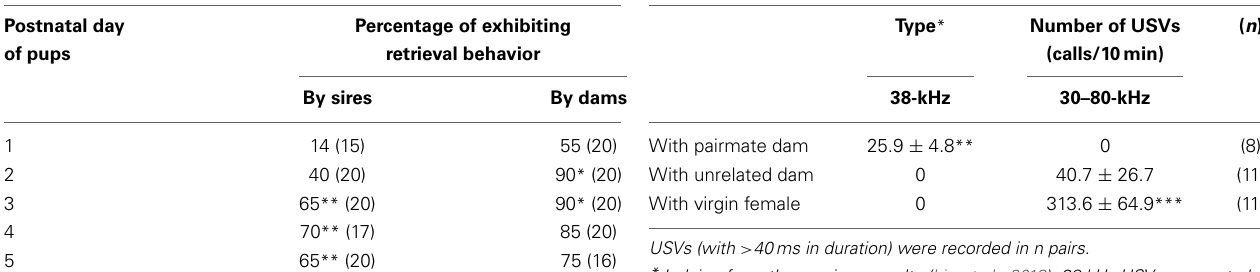
10-min period was observed in each case (E,I,M,S) . The number of sires displaying retrieval behavior was scored (F,J,N,T) . The numbers of positive mice/number of mice tested are shown in parentheses and expressed as percentages (U) . Two-tailed Fisher’s exact probability test: between sires separated alone (F) and together (J) or as a whole family (N) , ∗∗∗ P < 0 . 001 equally; between sires separated together (J) and as a whole family (N) , ∗∗ P < 0 . 01; between sires separated alone (F) and co-housed with unrelated dams (T) , not significant (n.s.); sires separated as a whole family (N) and co-housed with unrelated dams (T) , ∗ P < 0 . 05.